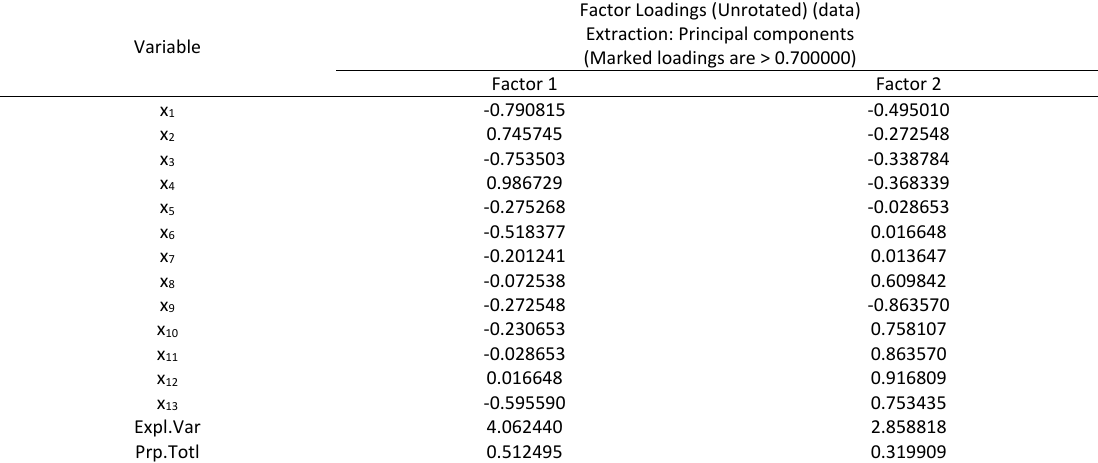
Тable 3: Results of factor analysis. Identification of COVID-19 virus restriction indicators (STATISTICA 10 Variable